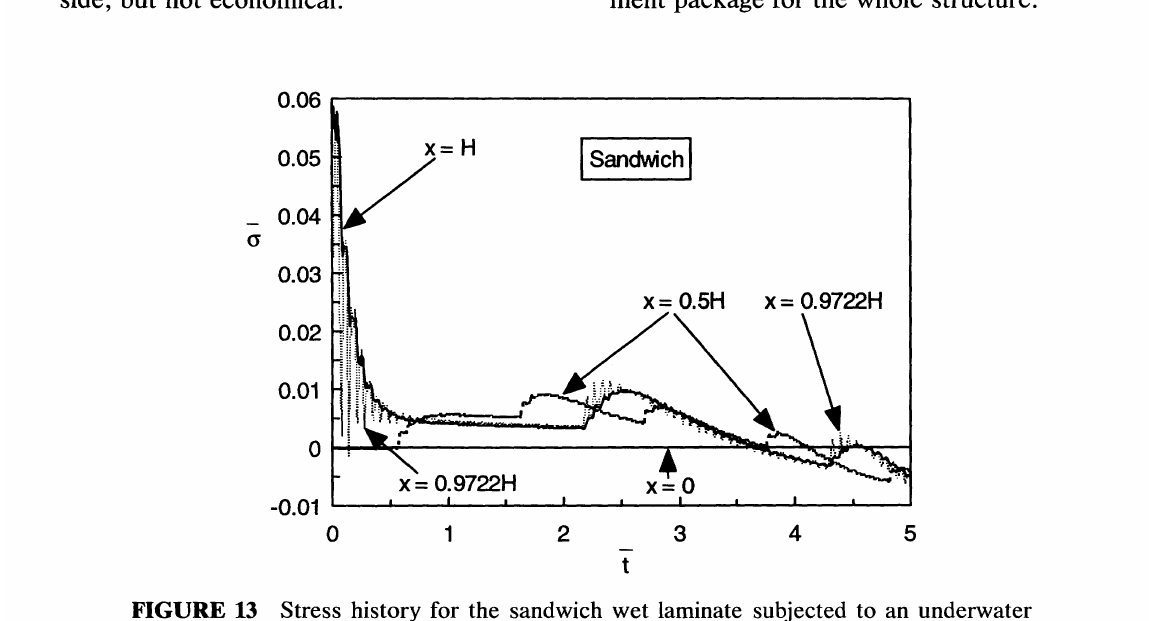
Stress history for the steel wet plate subjected to an underwater explosion: (-) x = H, ( ... ) x = 0.2H, (---) x = 0.9H; TNT, 20 kg, D = 2 m).